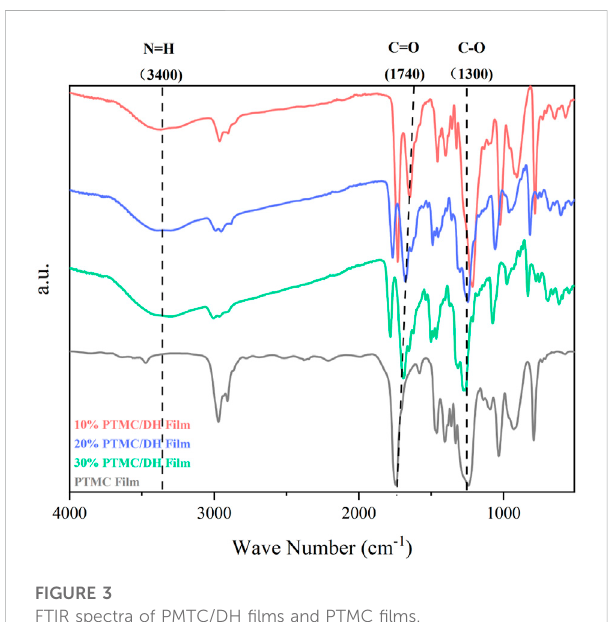
FIGURE 3 FTIR spectra of PMTC/DH fi lms and PTMC fi lms.